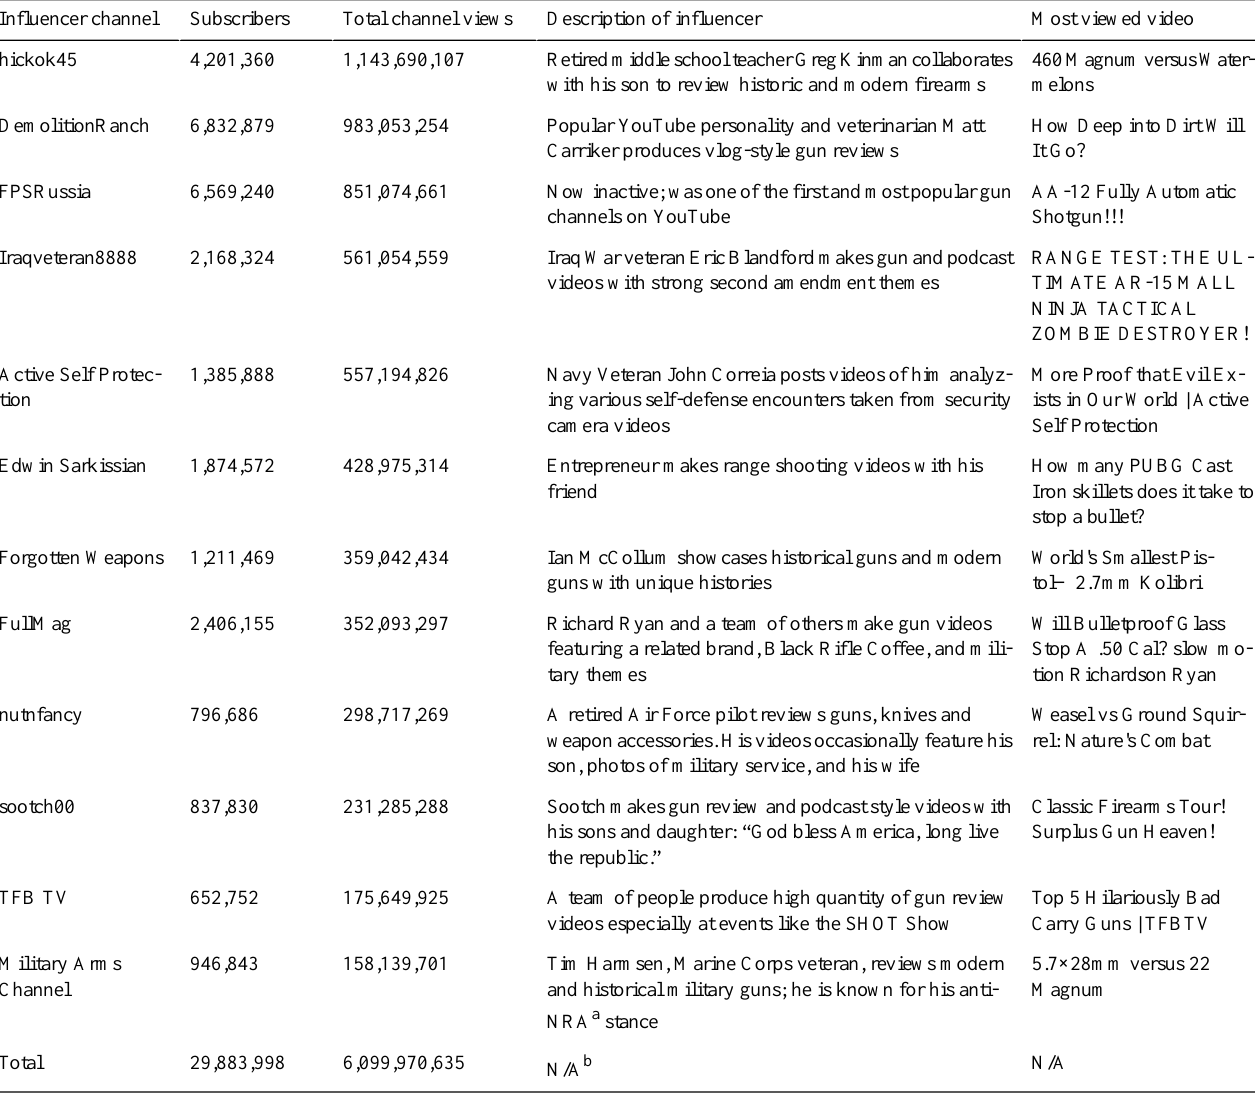
Table 4. Characteristics of YouTube firearm influencers by total channel